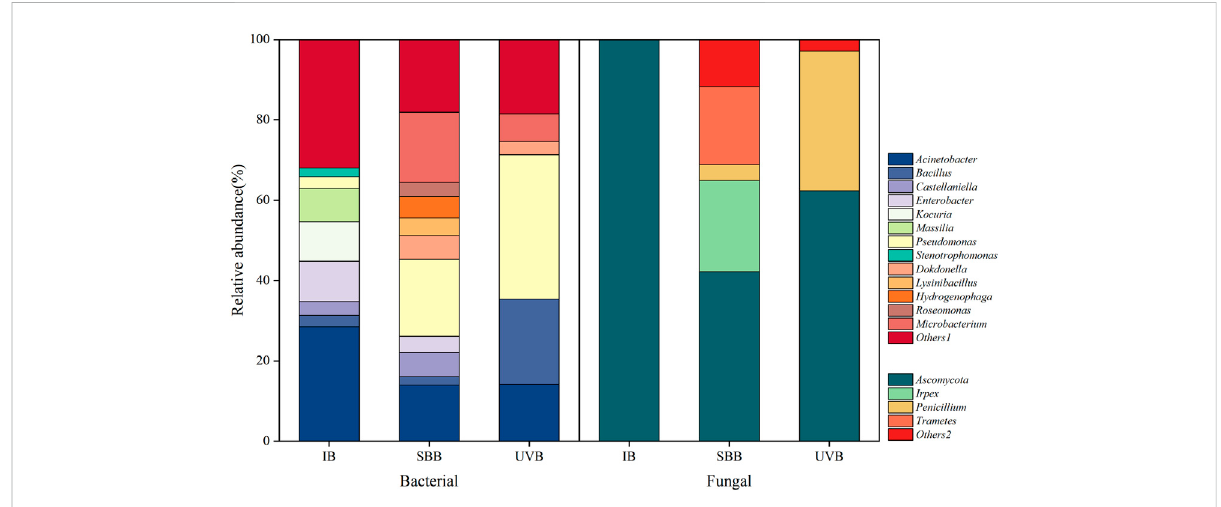
FIGURE 5 Distribution of bacterial and fungal population in bioaerosols from three